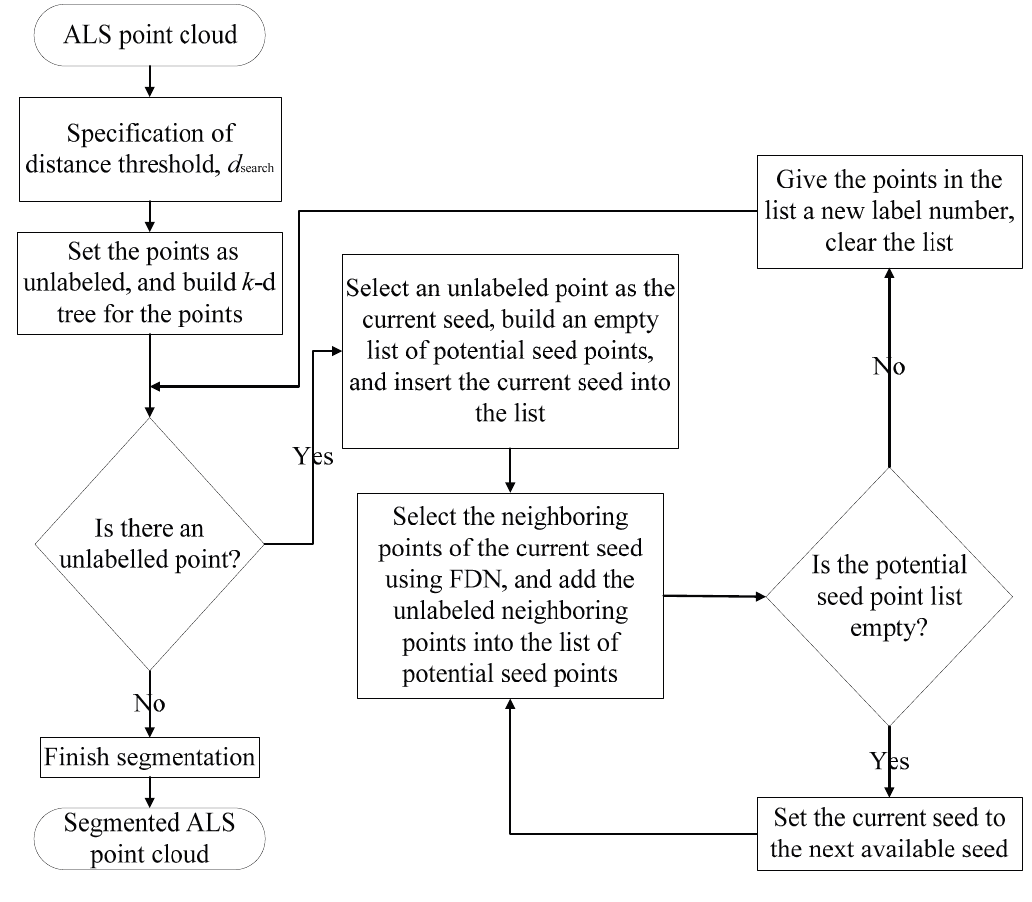
Figure 2. The work flow of 3D connected component analysis (CCA). FDN, fixed distance